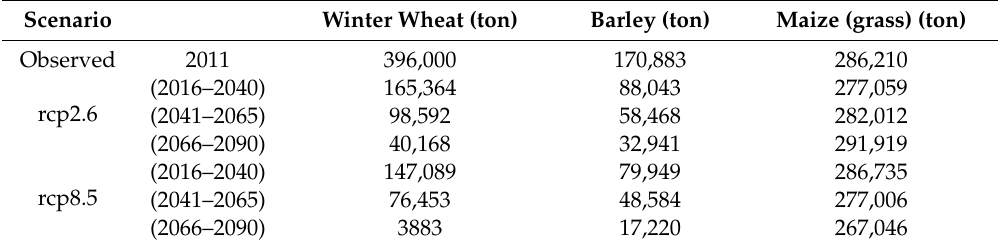
Table 11. Results of the total yield of the crops under the scenarios rcp2.6 and rcp8.5 for the periods 2016–2040, 2041–2065, and 2066–2090 versus the observed period in the Qazvin